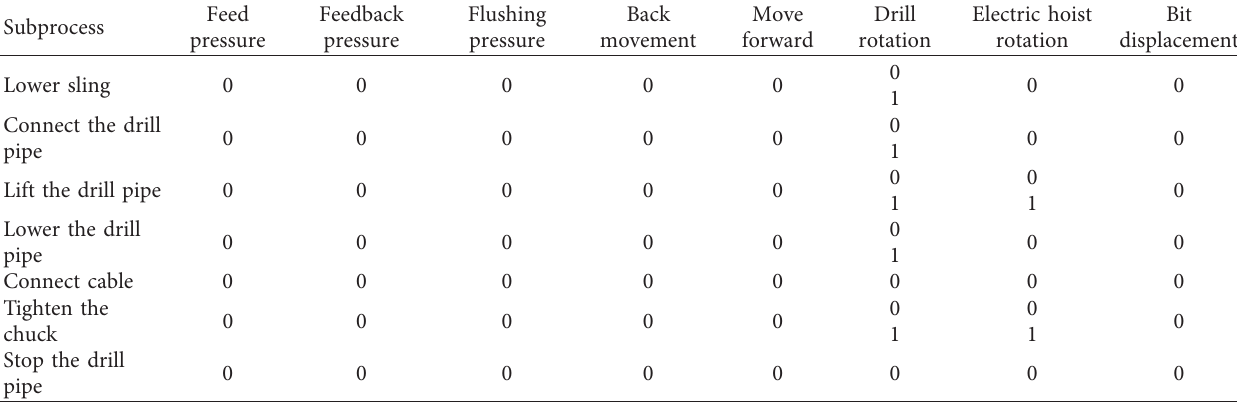
Table 1: The status of each working parameter in the process of loading the drill pipe.